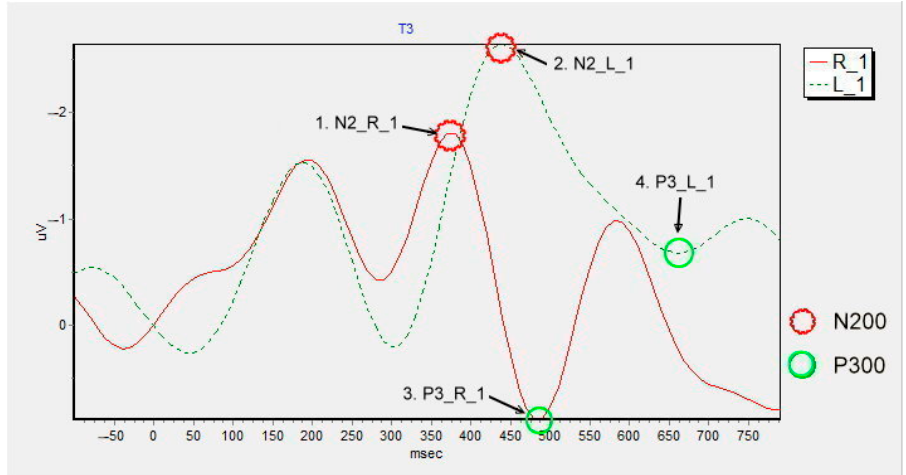
Figure 10. The delay situation of the components P300 and N200 in ERPs: The latencies of auditory P300 (marks 3 and 4) and N200 (marks 1 and 2) responses are longer than the theoretical latencies. The average waveforms at T3 is the first stage output of the 5th test run from participant